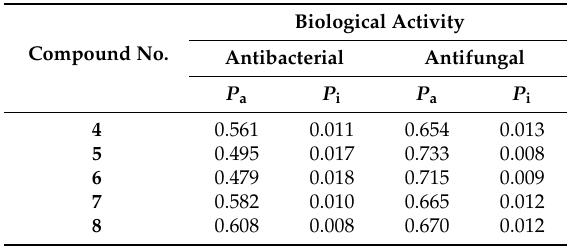
Table 2. Predicted biological activity of synthesized compounds using prediction of activity spectra for substances (PASS)